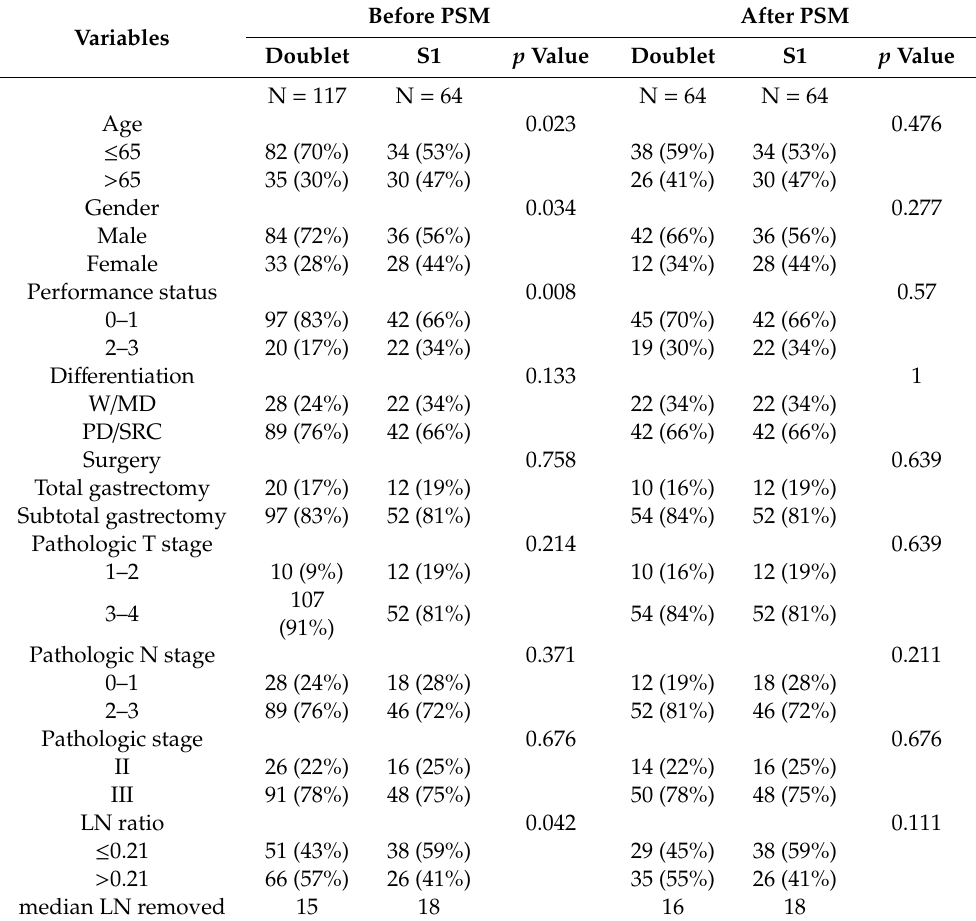
Table 1. Baseline patient characteristics of 181 patients with advanced gastric cancer receiving adjuvant chemotherapy, stratified by PSM.